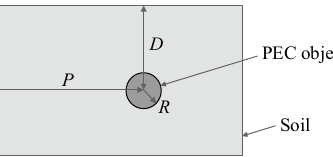
Figure 1. Buried object characterization problem: graphical illustration and definition of terms. Variables R , D , and P stand for the object radius, its depth, and lateral positions, respectively, all to be identified in the characterization process